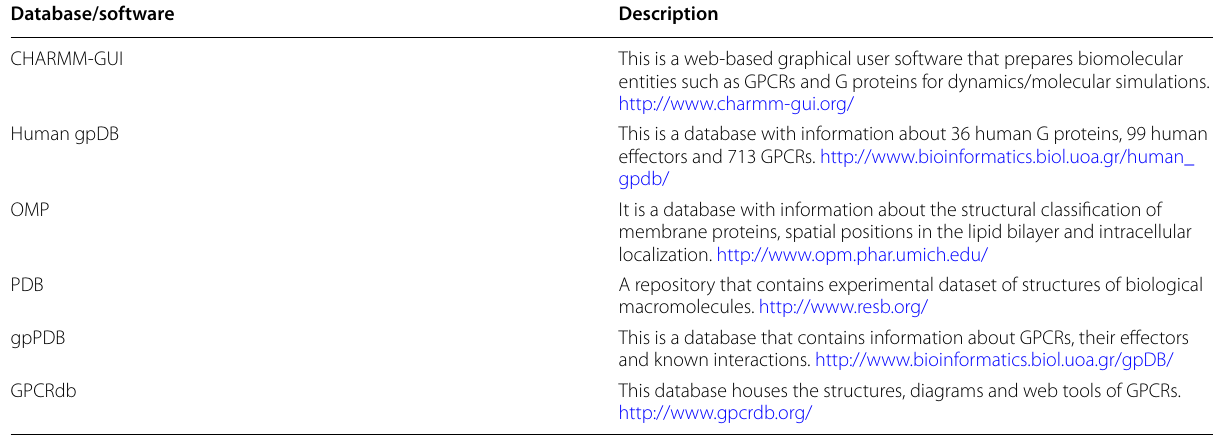
Table 1 Databases and software tools for GPCR–G protein modelling